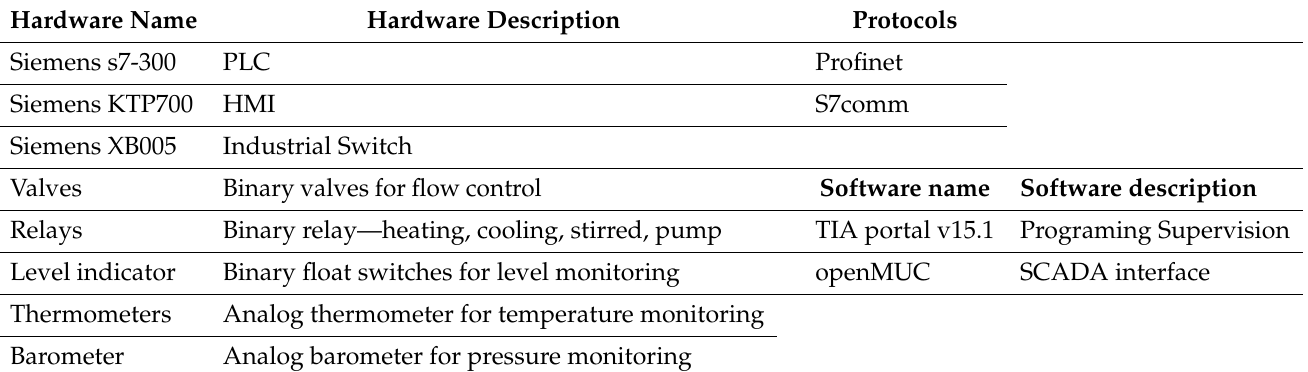
Table 5. Components of physical brewery